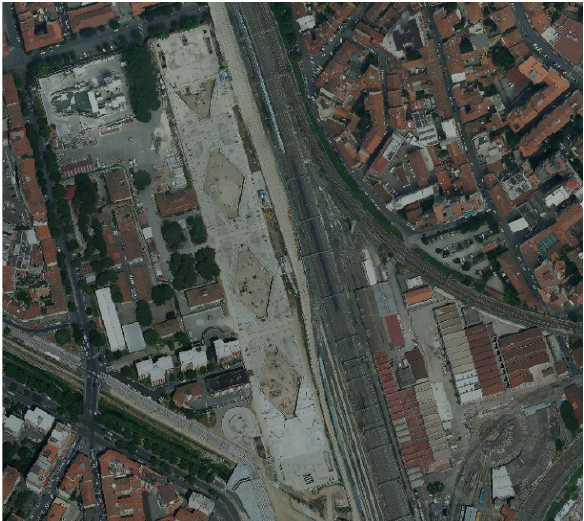
Figure 3 . High speed Florence railway station as in June 2019